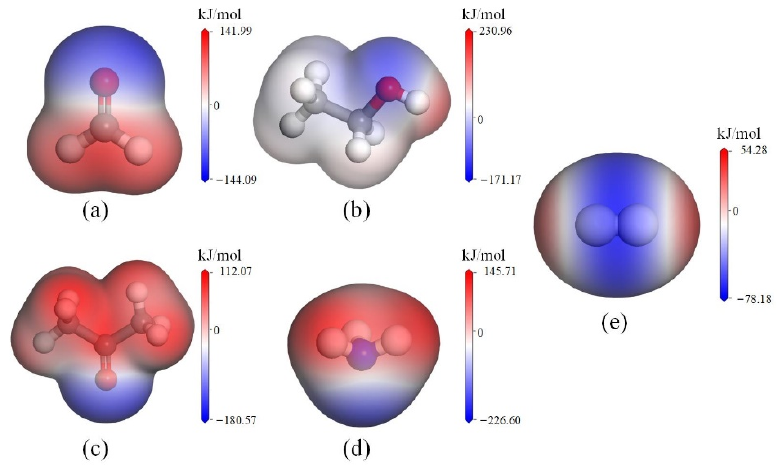
Figure 5. Molecular structures and computed electrostatic potentials on electron isosurfaces of ( a ) CH 2 O, ( b ) C 2 H 5 OH, ( c ) CH 3 COCH 3 , ( d ) NH 3 and ( e ) H 2 .